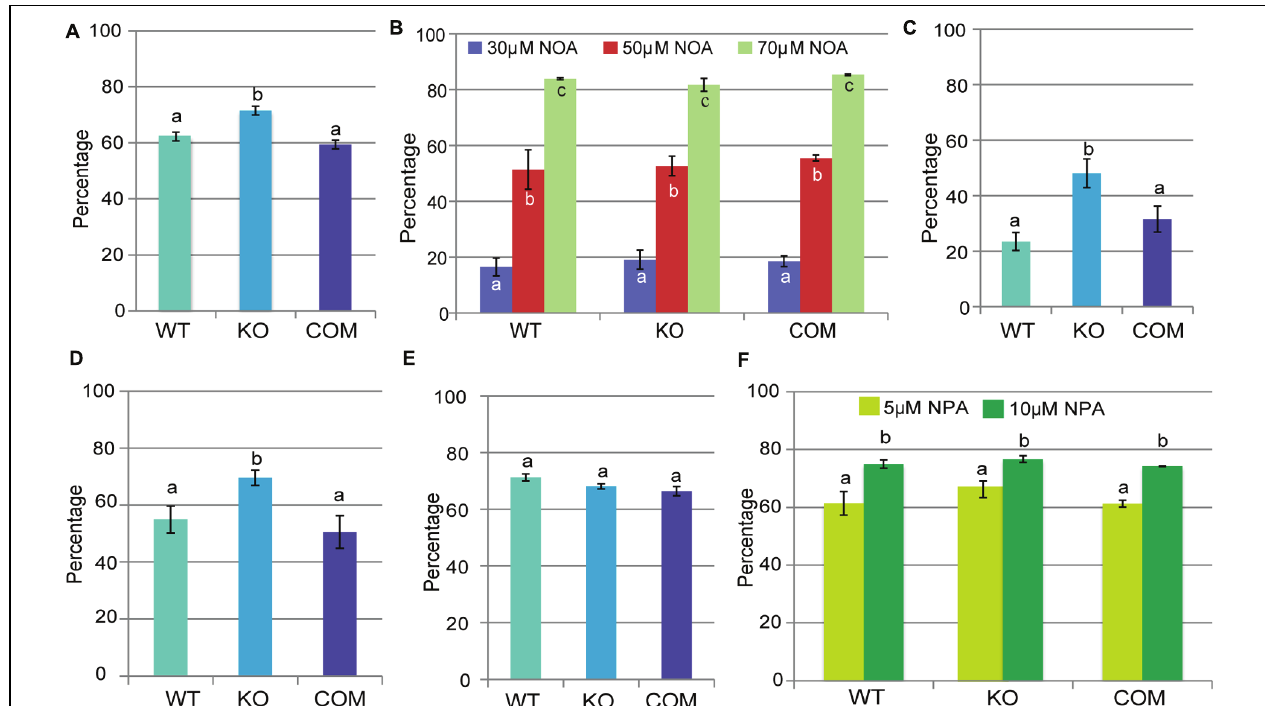
FIGURE 3 | tno1 roots show increased sensitivity to 2,4-D and IAA. Five-day-old seedlings were transferred to media with the indicated chemical or solvent as a control and root length was calculated after an additional 6 days of growth. Mean root growth of each genotype on the chemical treatment compared to the mean on the solvent control was expressed as percentage inhibition. Percent inhibition of root length on (A) 30 nM 2,4-D, (B) 1-1-napthoxyacetic acid (NOA; 30, 50, and 70 µ M), (C) 30 nM 2,4-D + 10 µ M 1-NOA, (D) 40 nM IAA, (E) 100 nM 1-NAA, and (F) 1- N -naphthylphthalamic acid (NPA; 5 and 10 µ M) for WT, KO, and COM lines are shown. Values represent analysis of three biological replicates with 20 seedlings for each set. Error bars indicate standard errors derived from means of the three replicates. Different letters indicate statistically significant differences ( P < 0.05) by a Student’s t